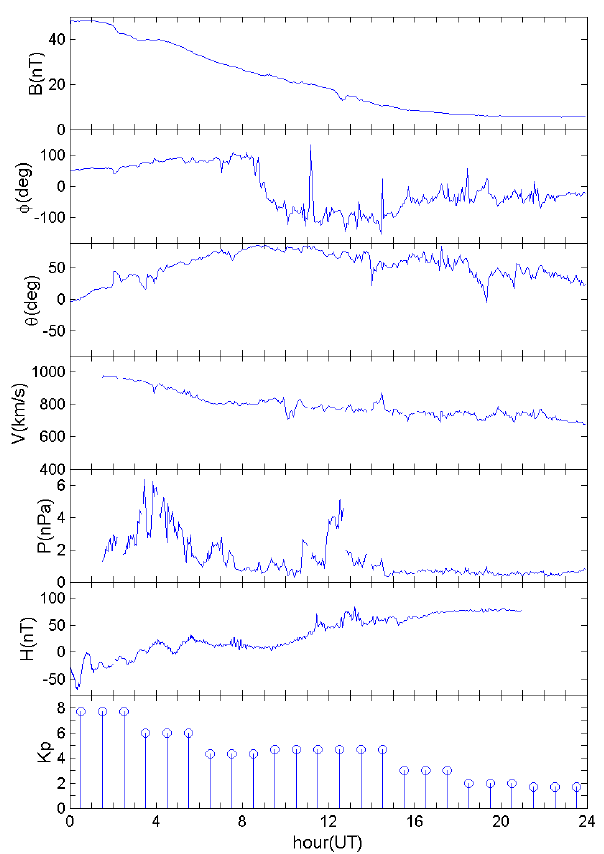
Fig. 1. ACE measurements, ground observations from AQU and K p index on 16 July 2000. From top to bottom are shown the IMF strength and its longitude and latitude in the ecliptic angular coor- dinates, the SW flow speed and dynamic pressure, the variations of the horizontal geomagnetic field component H at AQU and the K p index.